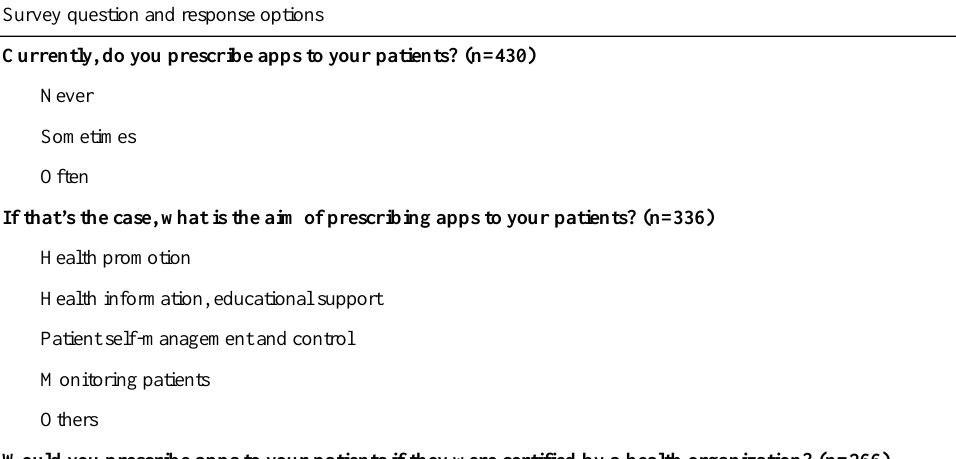
Table 3. Questions and answers about the prescription of health professional apps.